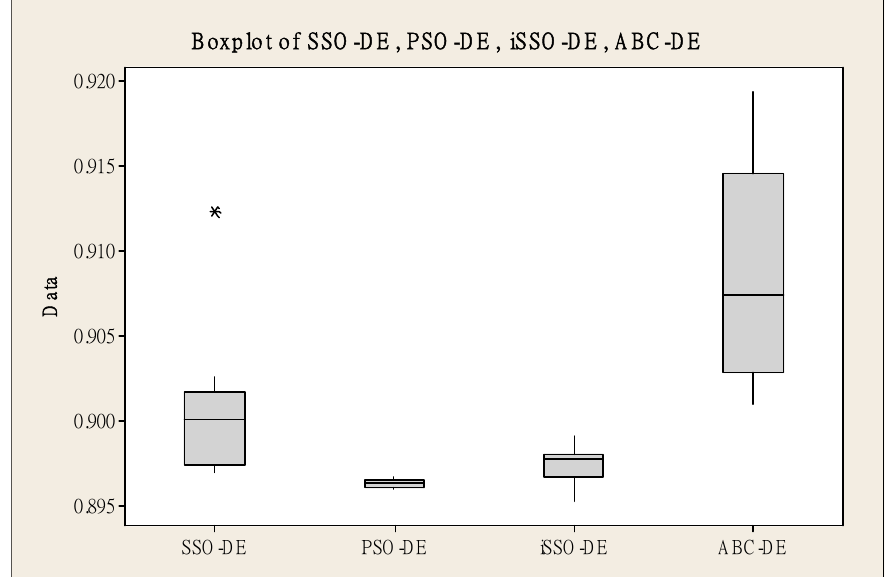
Figure 10. Box and whisker diagram for spring (autumn).